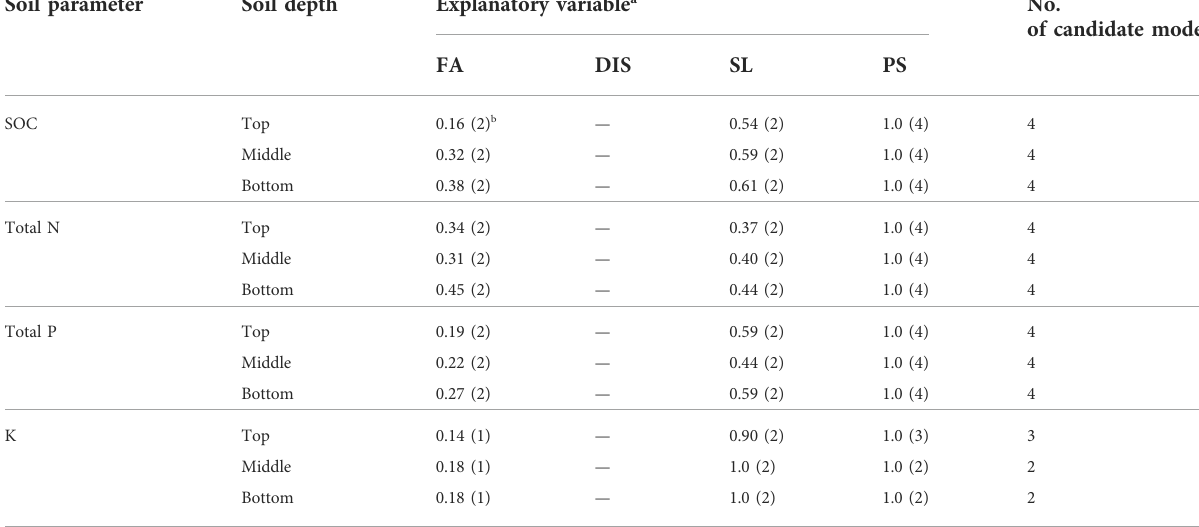
TABLE 5 The relative importance of site environmental attributes in the fi nal LMEM. Soil